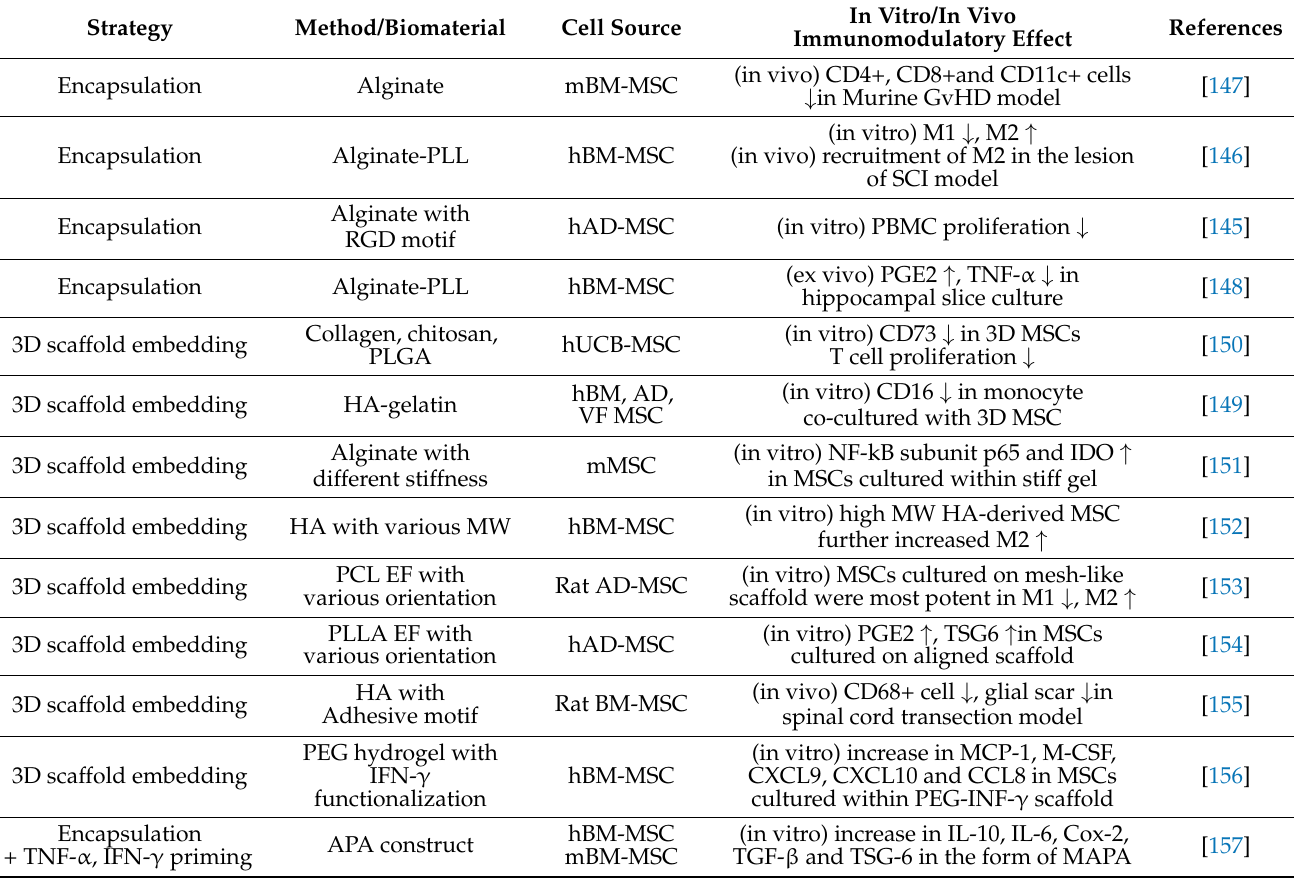
Table 4. The biomaterial-based structural modification of MSCs to boost immunomodulatory property. Strategy